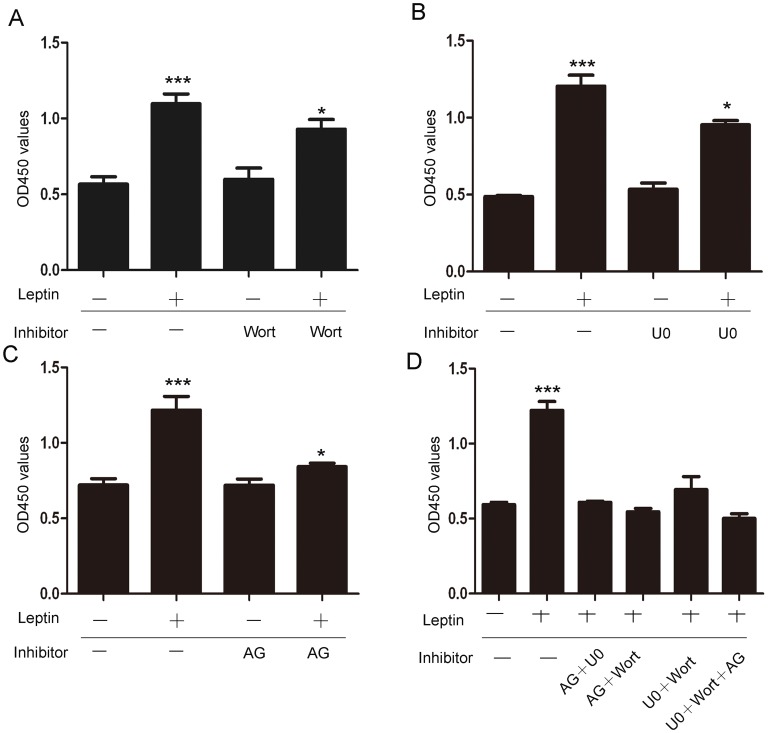
Leptin activates phosphoryolations of STAT3, Akt, and ERK1/2 in NP cells.After 1-day serum deprivation, leptin (10 ng/ml) was added into the serum-free medium of NP cells for 5 min, 15 min and 30 min, and then the protein amouts of phosphorylated forms of Akt (p- Akt) (A), ERK1/2 (p- ERK1/2) (B) or STAT3 (p- STAT3) (C) were detected with western blotting analysis. GAPDH was also detected for a loading control.